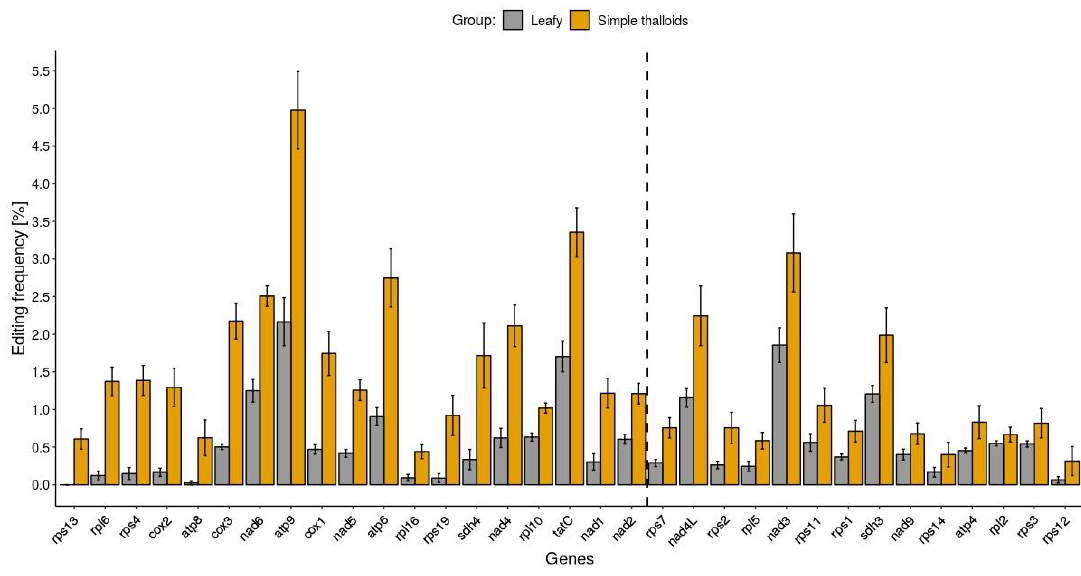
Figure 2. Predicted C-to-U editing frequency of liverwort genes. Bar plots depicting mean editing frequency of leafy ( n = 8) and simple thalloid ( n = 5) liverworts are colored by liverwort group. Genes are sorted in ascending order (left to right) of statistical significance of differences between editing frequencies. The significantly different ( p -value < 0.05) editing frequencies are depicted on the left side of vertical dashed line. The bar plot whiskers depict standard error values.